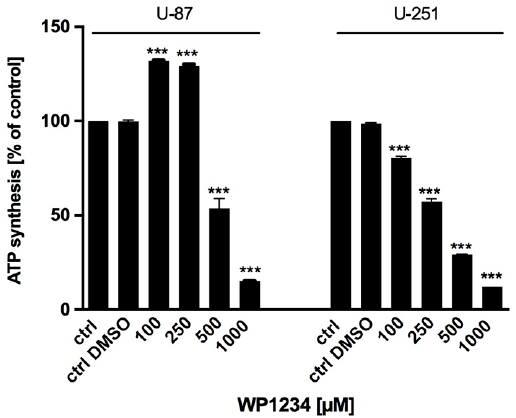
Figure 7. ATP synthesis assay showing glycolytic activity and ATP production of U-87 and U-251 cells after 72 h treatment with various concentrations of WP1234 (100–1000 µ M). Significant differences between the treatment and control (untreated cells) means are indicated by * p < 0.05, ** p < 0.01, *** p <